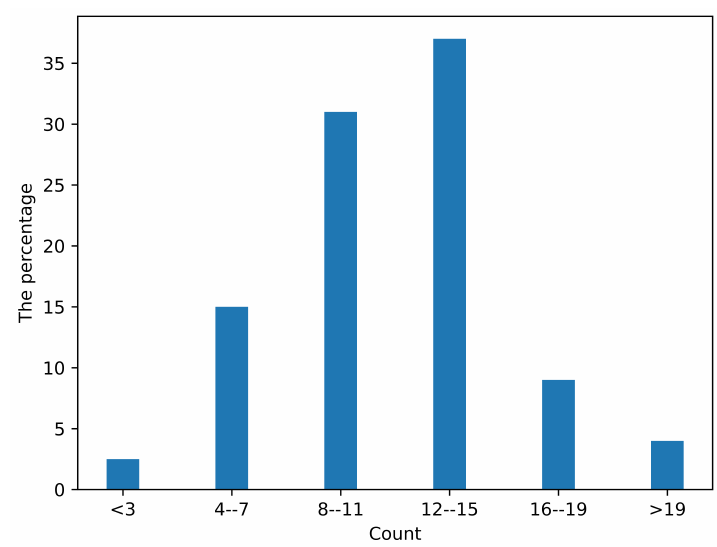
Figure 7. The distribution of image quantity per vehicle.